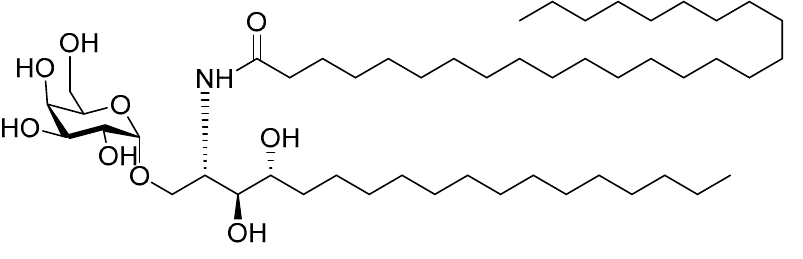
Figure 9. The chemical structure of α -GalCer.